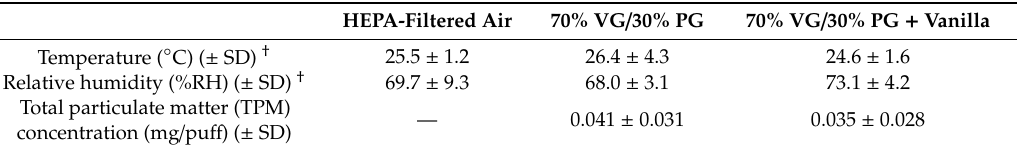
Table 1. Characterization of e-cig aerosol